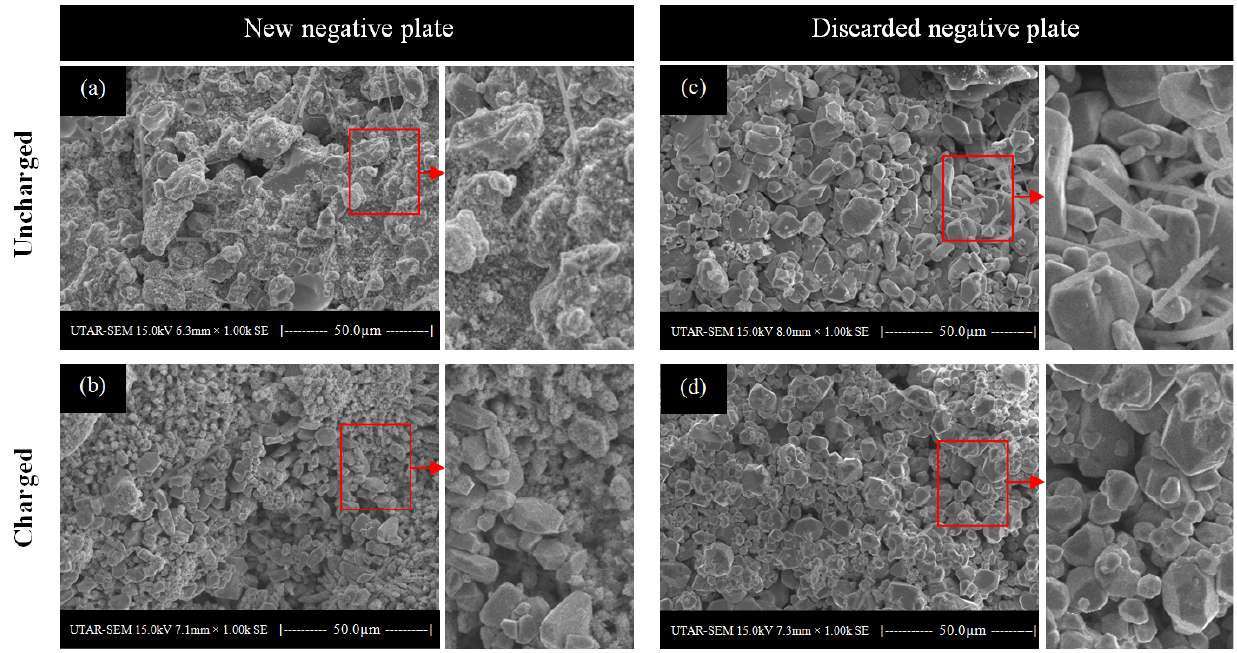
Figure 4. Microscopic scans of new negative plates ( a , b ) and discarded negative plates ( c , d ) before and after charging at 2.4 V.